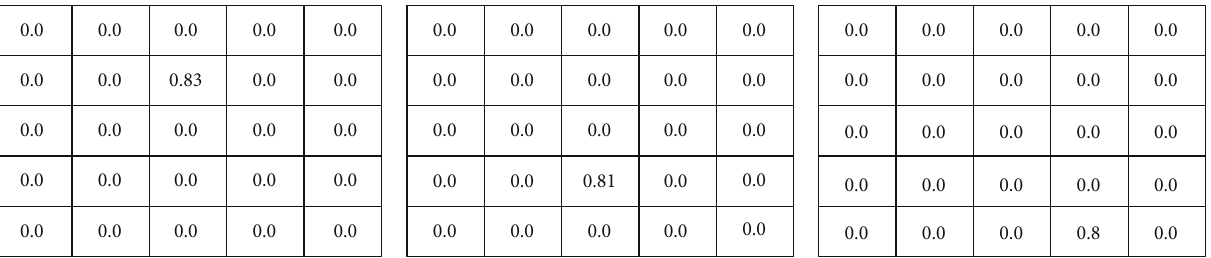
Figure 4: Sample slices of the 512 × 512 × 3 energy array, which shows the rate of change in the remaining energy and the movement of the node.